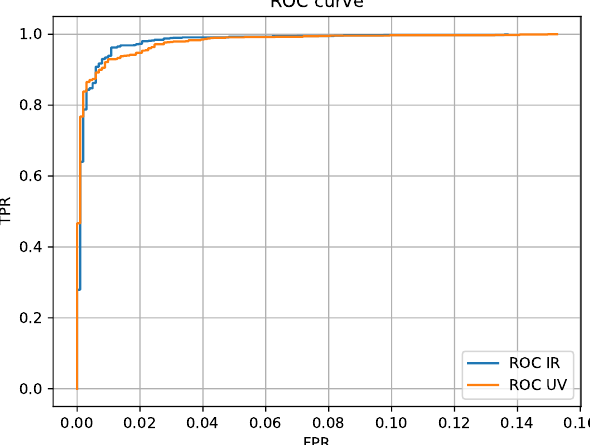
Figure 7. Receiver Operating Characteristic (ROC) curve for IR and UV neural network approaches.